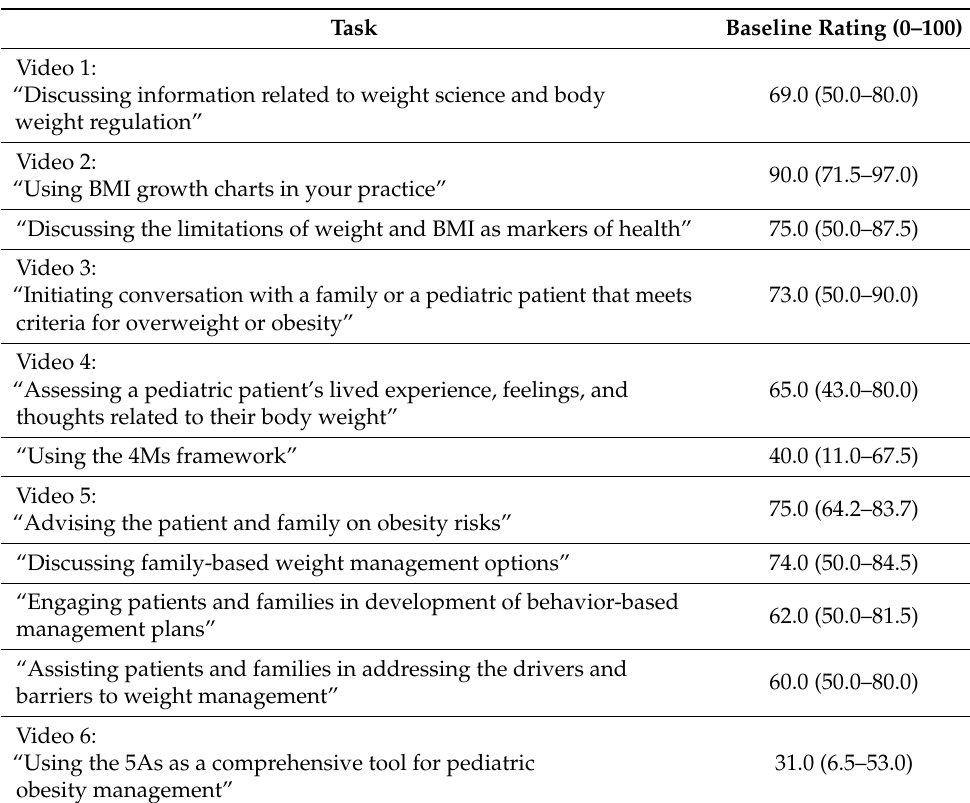
Table 5. Baseline self-efficacy scores 1